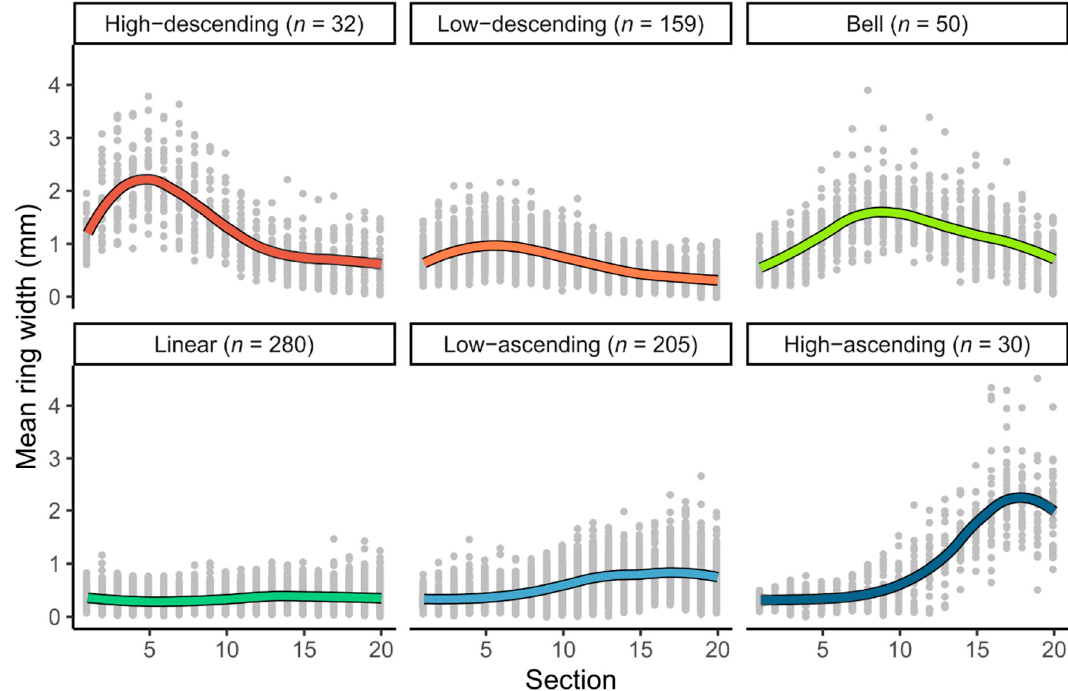
Figure 2. Scatterplots of the growth patterns identified using a k-means cluster algorithm. Gray dots represent the values of each segment of the 20-segment series of the trees constituting the clusters. We obtained black lines using loess smoothing of the data with a 50% span. “ n ” indicates the number of sampled trees per cluster.